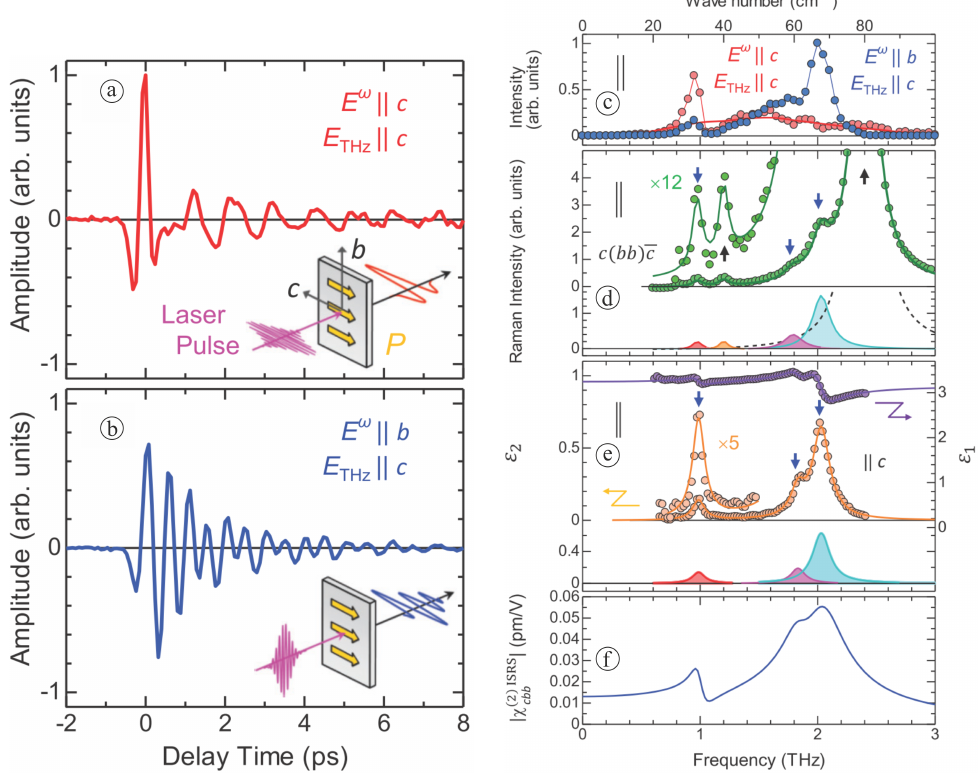
Figure 22. X-axis component of THz waveforms for ( a ) E ω || c and ( b ) E ω || b . ( c ) Intensity spectra of THz radiation for E ω || c and E ω || b . ( d ) Raman scattering spectrum in the c ( bb ) ¯ c configuration, which can be fitted by assuming five Raman modes (shaded area and dotted line). ( e ) Real (cid:101) 1 and imaginary (cid:101) 2 parts of the dielectric constant spectrum along the c axis, which can be reproduced by three Lorentz oscillators (shaded area). ( f ) Evaluated spectrum of the second-order nonlinear susceptibility | χ due to the impulsive stimulated Raman scattering. Reprinted with permission from [227]. Copyright 2022 by the American Physical